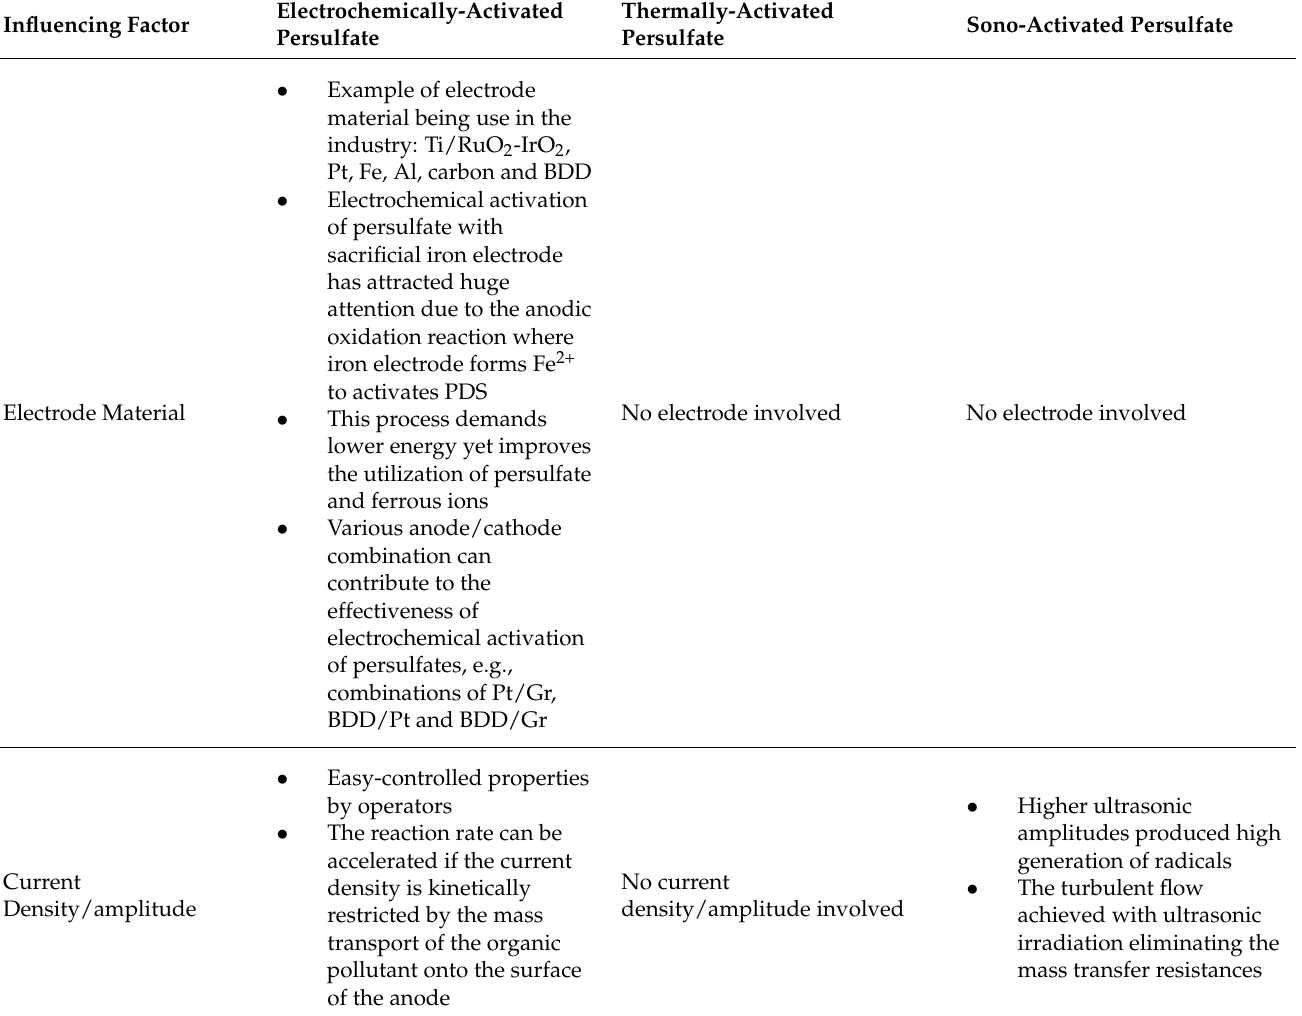
Table 4. Summarization of the important factor affecting the persulfate activation